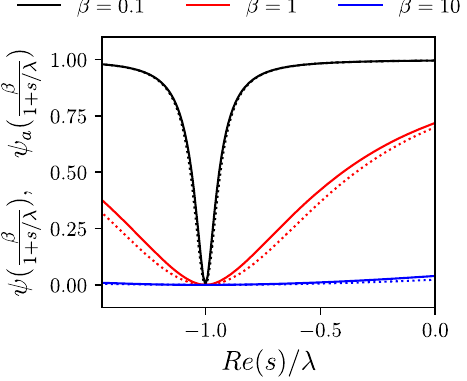
FIG. 7. Comparison between ψ ð z Þ (solid lines) and ψ a ð z Þ (dotted lines) for z ¼ β = ð 1 þ s= λ Þ for real values of s and various values of β .